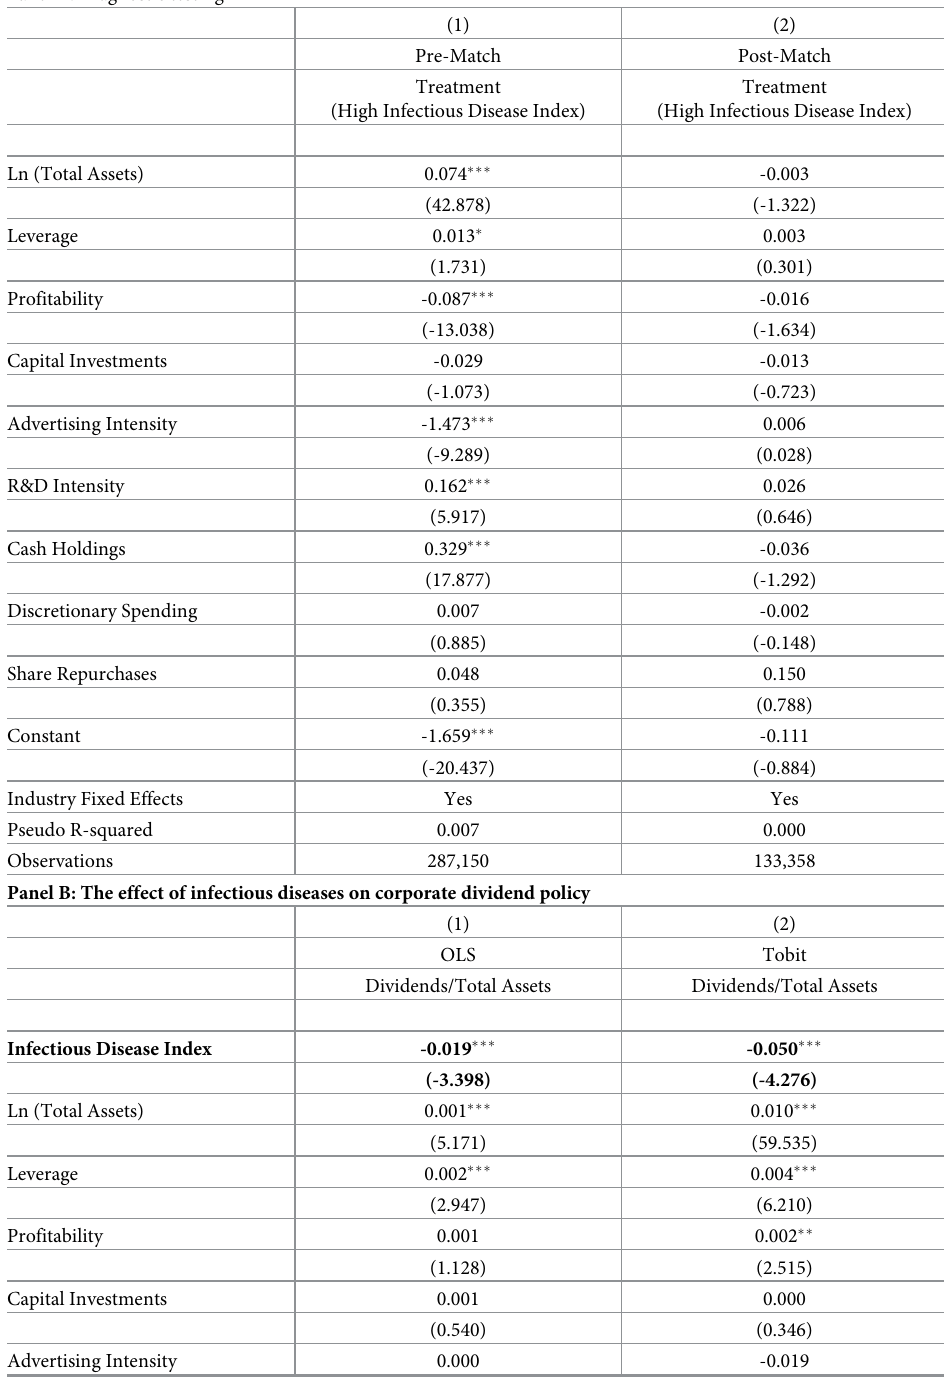
Table 5. Propensity score matching (PSM). Our measure of disease-related uncertainty is the infectious disease equity market volatility developed by Baker et al. (2020) [9]. Using sophisticated textual analysis, Baker et al. (2020) [9] search for news articles related to infectious diseases and equity market volatility. A higher fraction of these news arti- cles to all articles in each time period signifies a higher level of market uncertainty that can be ascribed to infectious dis- eases. For ease of interpretation, we have the infectious disease equity market volatility index divided by